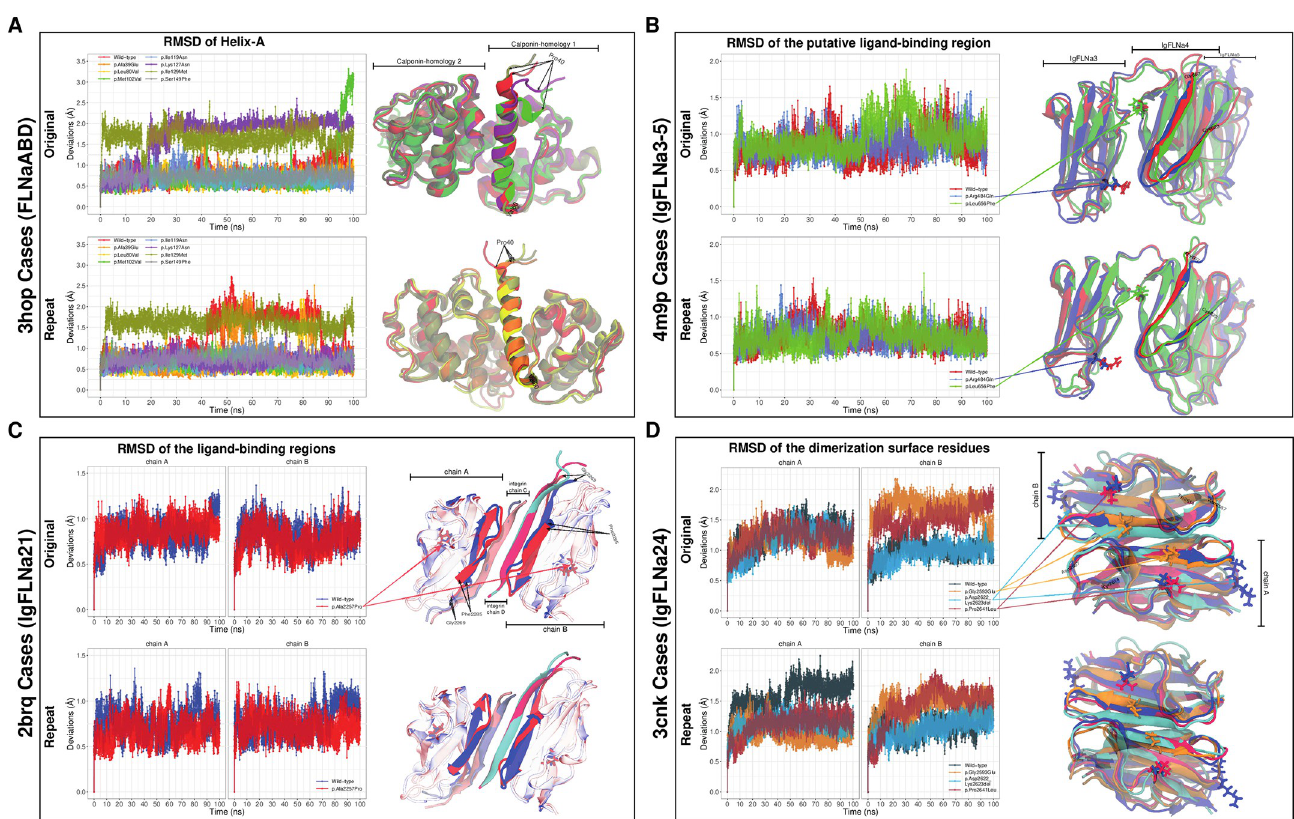
Fig 5. Backbone root-mean-square deviations (RMSD) and visualizations of known critical regions for cell migration. The following structural parts of filamin-A (FLNa) were represented: (A) FLNaABD, (B) IgFLNa3-5, (C) IgFLNa21 and (D) IgFLNa24. The critical regions were helix-A, a putative ligand-binding site, a ligand-binding site and dimerization interface for these parts,